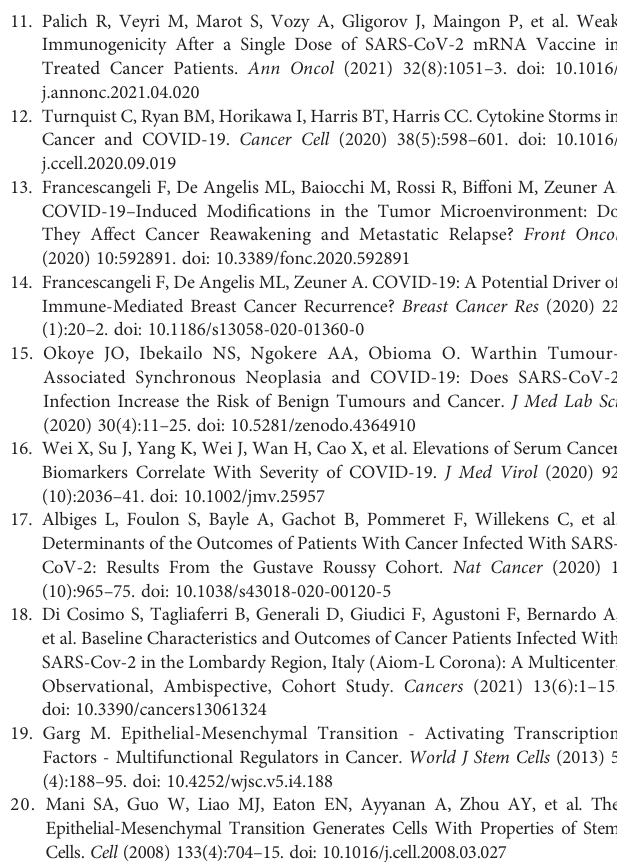
Supplementary Figure 1 | MDA-MB-231 cells showed higher expression of SARS-CoV2 binding receptors, ACE2 and TMPRSS2, in comparison to MCF-7 cells. BCC were stained with primary antibodies, including rabbit Anti-ACE2 antibody (GTX101395, Genetex, Irvine, CA, USA) or rabbit Anti-TMPRSS2 antibody (GTX81494, Genetex) following by secondary antibody Goat Anti-rabbit Igg DyLight488 (GTX213110-04, Genetex). The expression of ACE2 and TMPRSS2 was examined by fl uorescence activated cell sorting (FACS) analysis. Supplementary Figure 2 | Full-length blots of Western blot fi gures. (A) Protein expression ofp65andp50 inMDA-MB-231 and MCF7 cells,which showninFigure 2B. (B) The phosphorylation of STAT3 protein in MDA-MB-231 and MCF7 cells, which shown in Figure 3A. (C) The phosphorylation of STAT3 protein in MDA-MB- 231 and MCF7 cells in the present of NF k B inhibitor, which shown in Figure